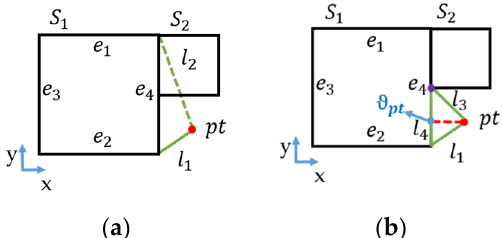
Figure 10. Adjustment rule: ( a ) triangle intersecting with square and ( b ) triangle after modification. pt means a bpp point. S 1 − 2 represent two interior squares. l 1 − 4 mean the edges of the triangle. ϑ pt is the projection point. The purple point is the vertex point closest to ϑ pt in S 2 .